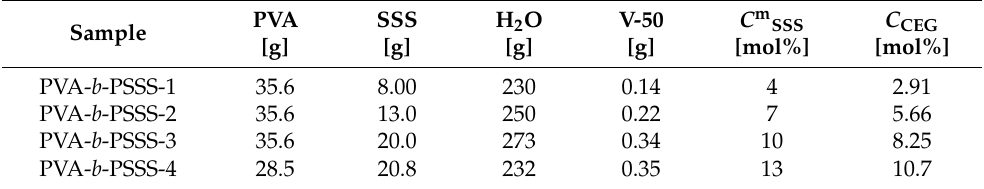
Table 1. Reaction conditions of PVA- b -PSSS block